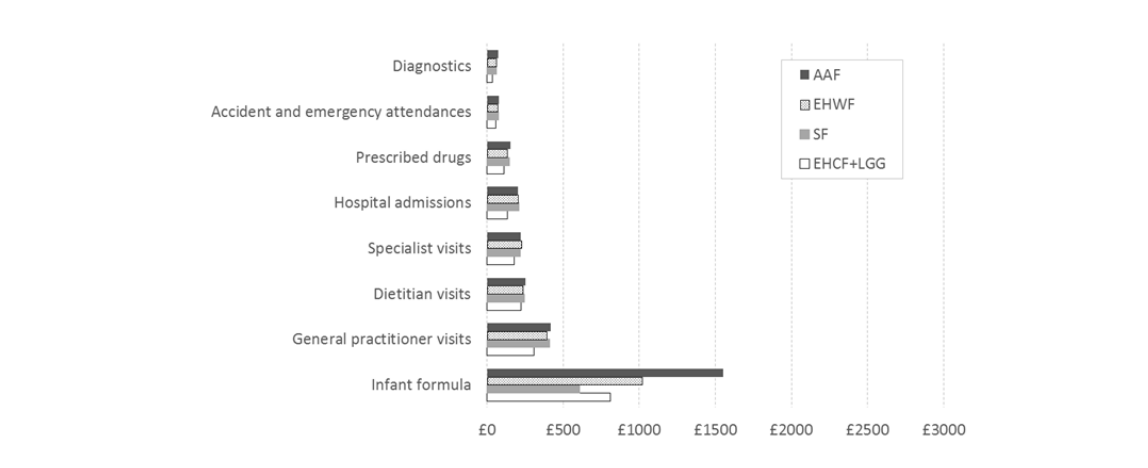
Figure 2. Resource Consumption in the Cost-effectiveness